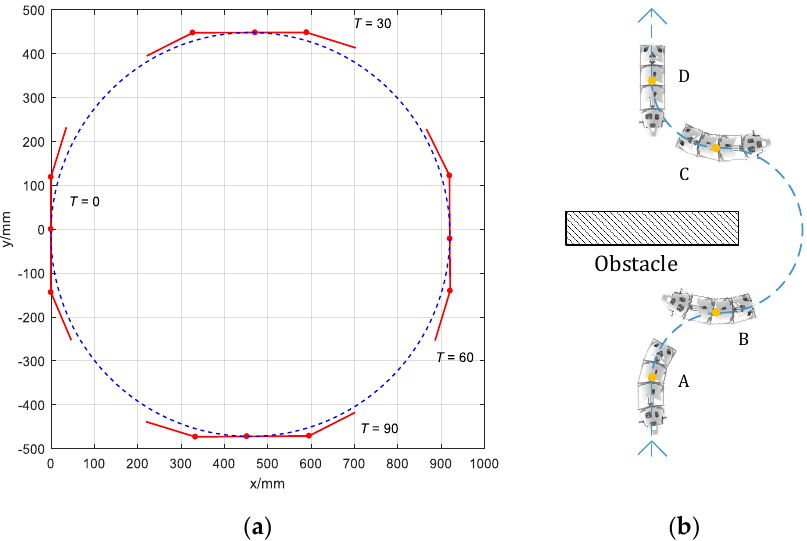
Figure 12. ( a ) Simulation diagram of the motion trajectory of the robot. The blue dotted line in the figure indicates the trajectory of the robot’s center point in 120 cycles (at the initial phase: L 2 = 400 mm). The red line in the figure indicates the specific position and posture of the robot when T = 0, T = 30, T = 60, and T = 90. The red dot in the figure is the three bearing hinge points of the robot. It can be seen that during the steering process, the motion trajectory of the robot is circular, and the radius is related to the initial state. ( b ) In a particular case, the robot can avoid an obstacle through adjusting the values of L 1 and L 2 at each of the following points: 1) A: L 1 = 534 mm, L 2 = 390 mm; 2) B: L 1 = 400 mm, L 2 = 523 mm; 3) C: L 1 = 534 mm, L 2 = 390 mm; and 4) D: L 1 = 461.4 mm, L 2 = 461.4